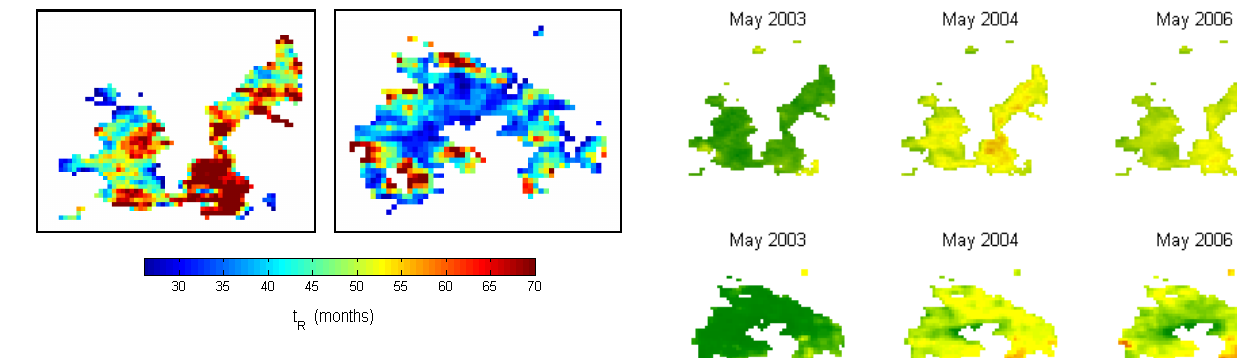
Fig. 6. As in Fig. 3, but with respect to the recovey time, t R .